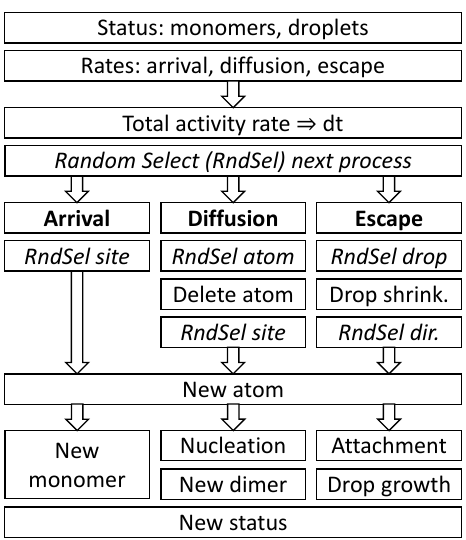
Figure 5. Scheme of a single loop of the kinetic Monte Carlo simulation